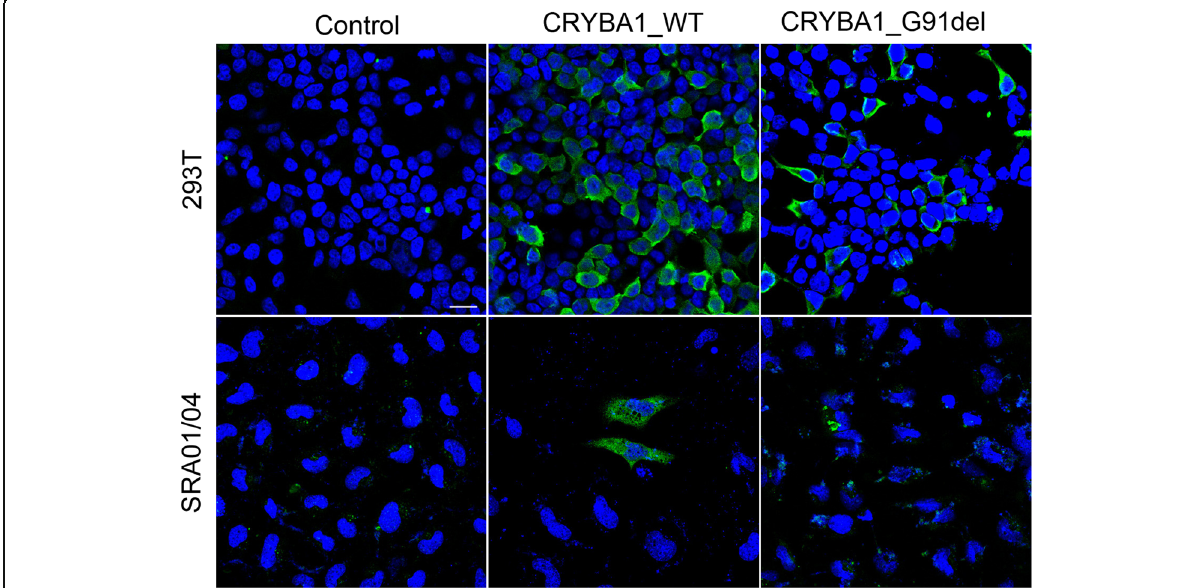
Fig. 5 Immunofluorescence staining of exogenous WT and mutated CRYBA1 in 2 cell lines. After the WT and deleted forms of CRYBA1 cDNA constructs were transfected into 293 T and SRA lines, cells were stained with FLAG primary antibody. p.G91del mutation led to greater aggregation of the protein at the cell membrane. Blue: nuclear; green: exogenous CRYBA1, scale bar: 20 μ